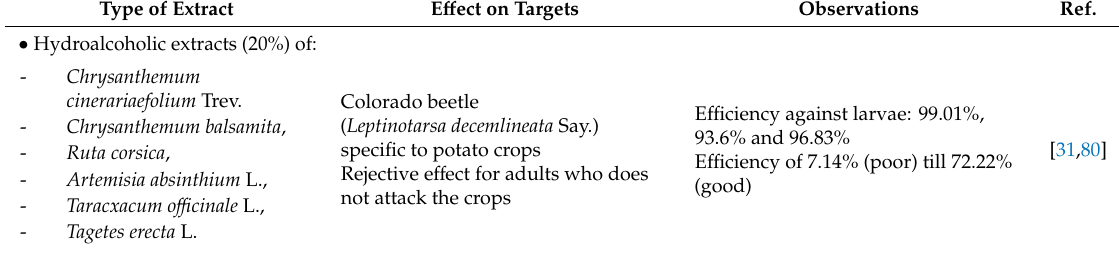
Table 5. Practical use of extracts from Romanian spontaneous flora. Type of Extract E ff ect on Targets Observations